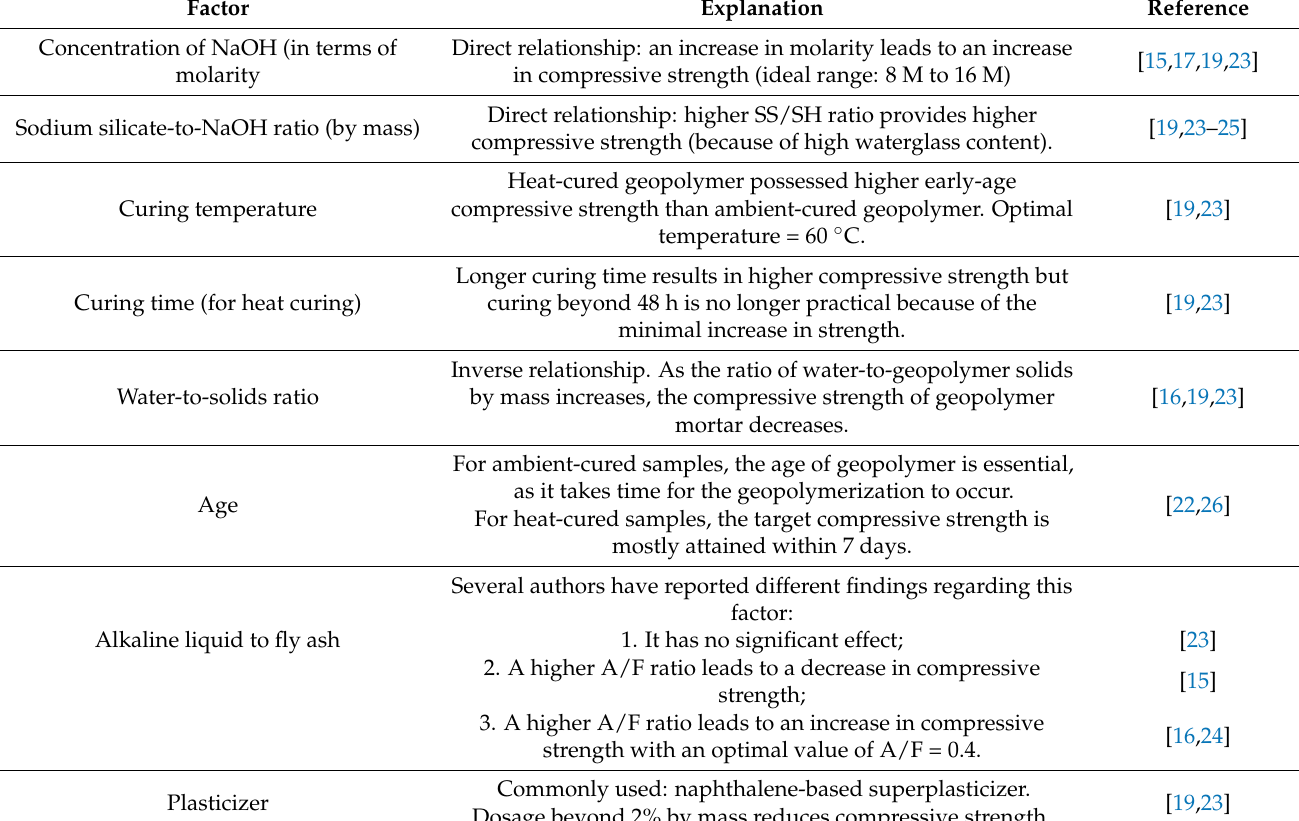
Table 1. Studies on low-calcium FA geopolymers and the factors that affect the compressive strength. Factor Explanation Reference Concentration of NaOH (in terms of Direct relationship: an increase in molarity leads to an increase molarity Sodium silicate-to-NaOH ratio (by mass)